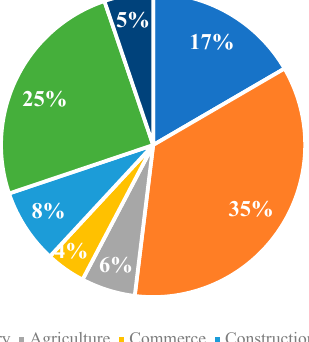
Figure 14. Sector contributions of the demand change between carbon neutral and carbon peaking policies.